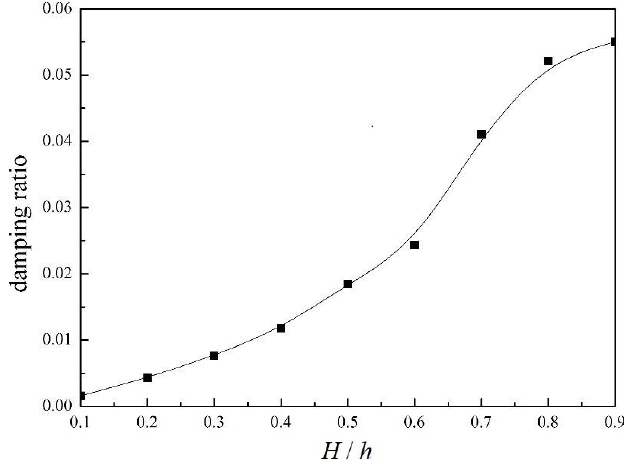
Figure 9. Sloshing damping ratio in the tank ( L = 1 m, h = 0.5 m) under different baffle heights.